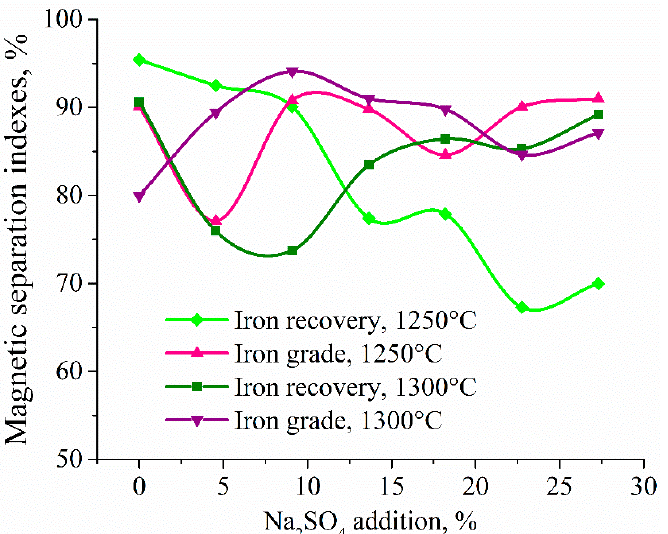
Figure 11. E ff ect of the Na 2 SO 4 addition to the red mud sample B roasted at 1250–1300 ◦ C during Figure 11. Effect of the Na 2 SO 4 addition to the red mud sample B roasted at 1250–1300 °C during 180 180 min on iron recovery and grade of magnetic min on iron recovery and grade of magnetic concentrate.